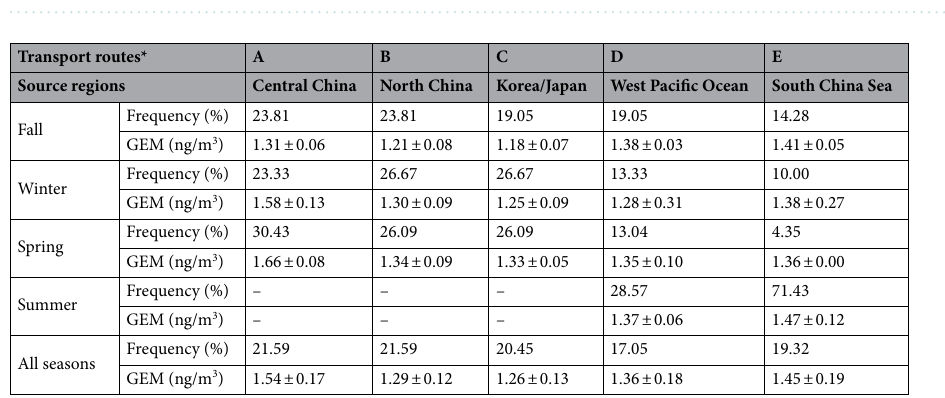
Table 2. Occurrence frequency and route-based average GEM concentration for different clustered transport routes moving toward the Taiping Island. * The transport routes are clustered in Fig. 6.